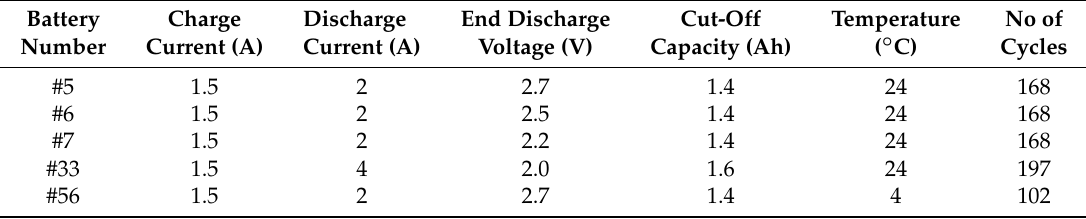
Table 1. List of batteries with their operating